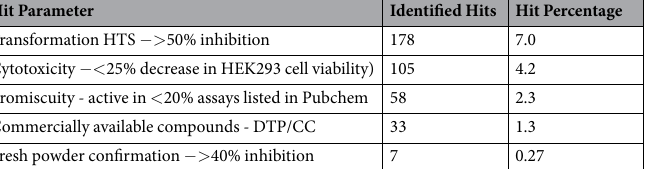
Table 1. Funnel Strategy − 2,532 compounds screened. Abbreviations: HEK293, human embryonic kidney; DTP, Developmental Therapeutics Program; CC, Cayman